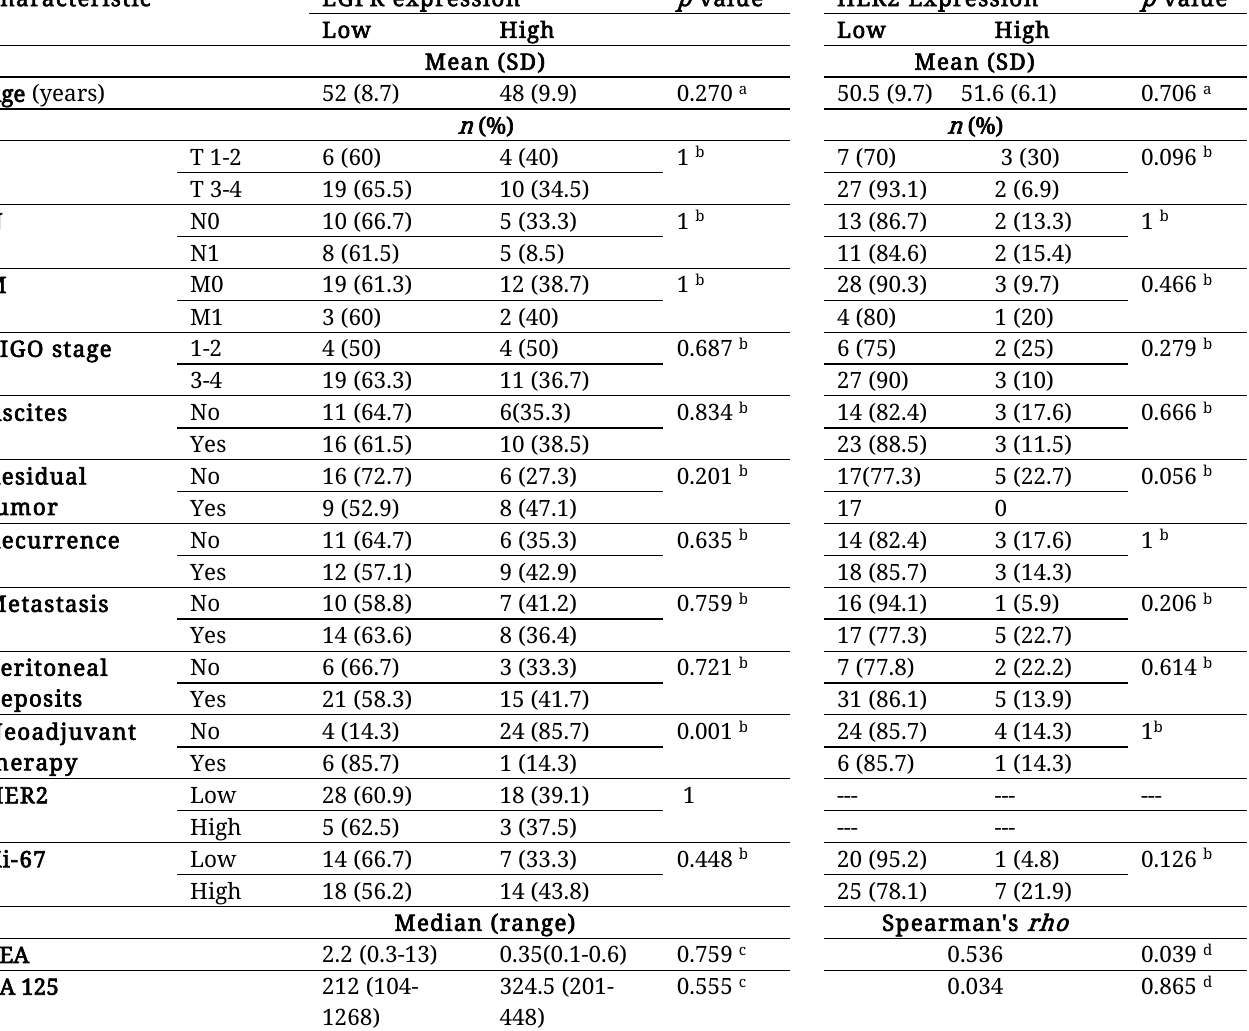
Table 2: The relation between EGFR and HER2 expression and patients’ clinicopathological characteristics Characteristic EGFR